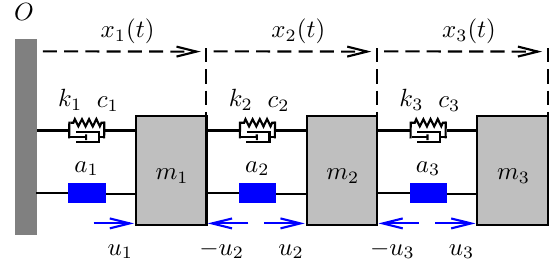
Figure 2: Mechanical system with active force actua- tion